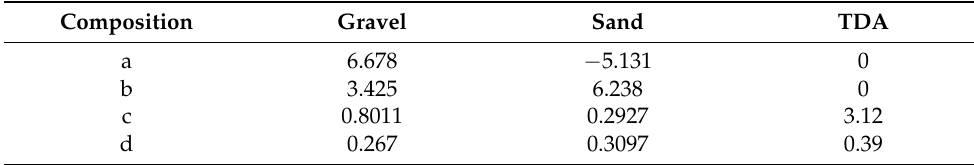
Table 3. Values of a, b, c, and d in the volume change